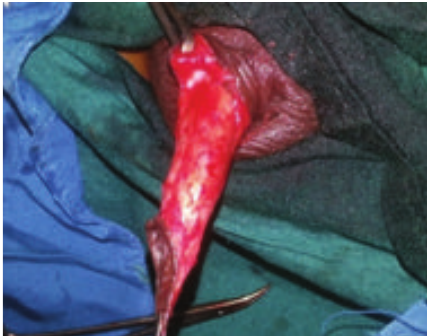
Figure 2: Penis degloved leaving scar tissue at the end which was excised.